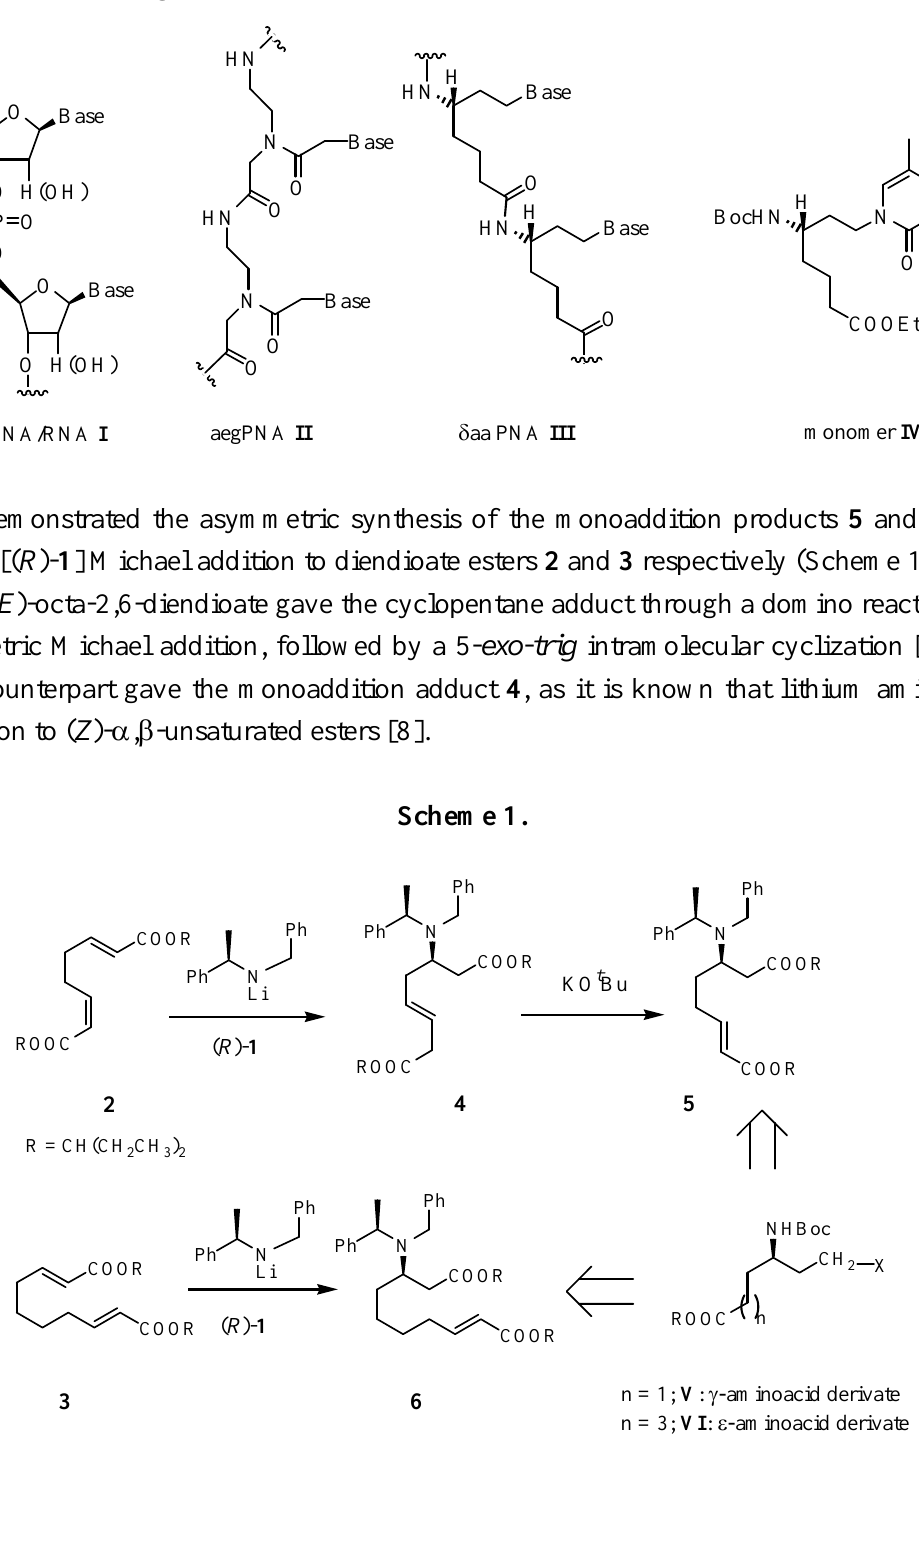
Figure 1 . Structure of DNA, PNA and modified